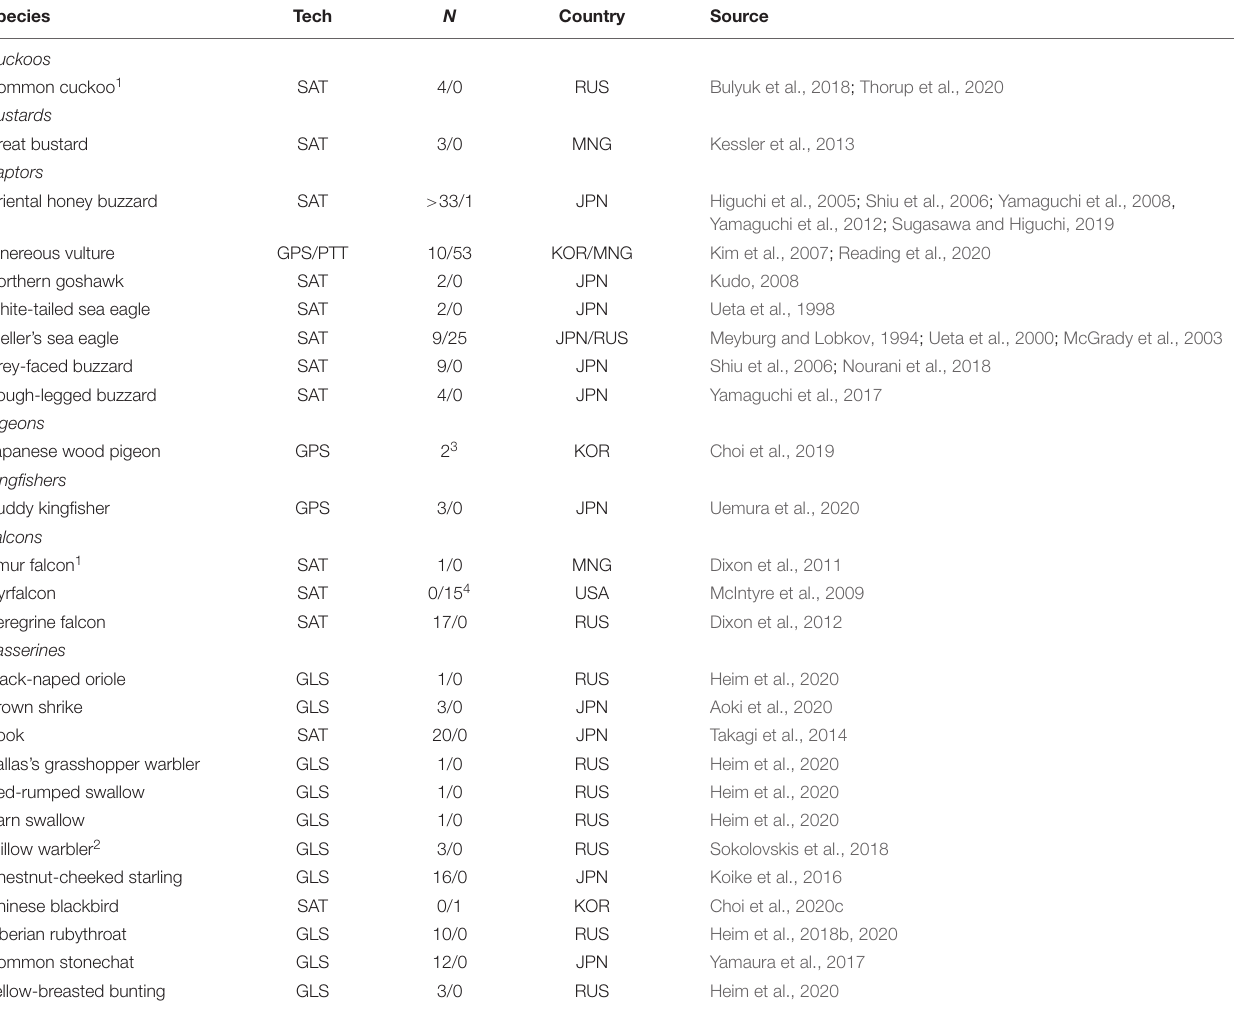
TABLE 2 | East Asian landbird migrants for which tracking data have been published in the peer-reviewed literature ( n = 23) with the tracking technique (Tech) used for each species (GLS = light-level geolocation, GPS = Global Positioning System data logging and SAT = satellite tracking), the number of individuals tracked (N, adults/juveniles), the country where the birds were tagged (RUS = Russia, MNG = Mongolia, JPN = Japan, USA = United States of America), and the source(s) where the original data were